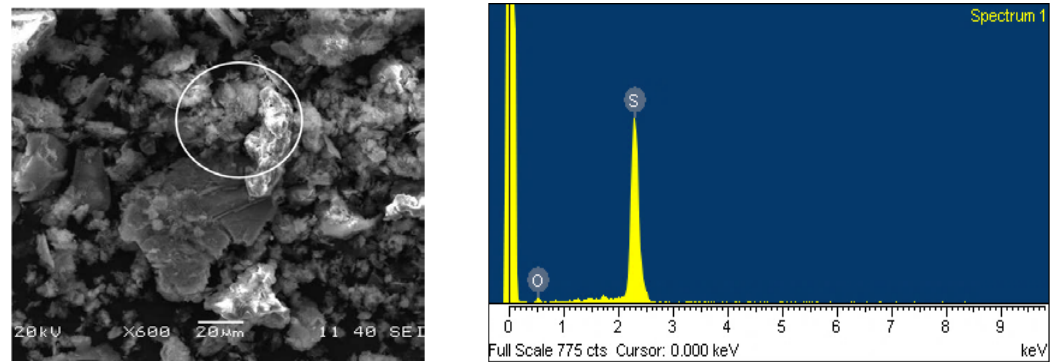
Figure 6. SEM micrograph and EDS spectrum of residue (Test 9).